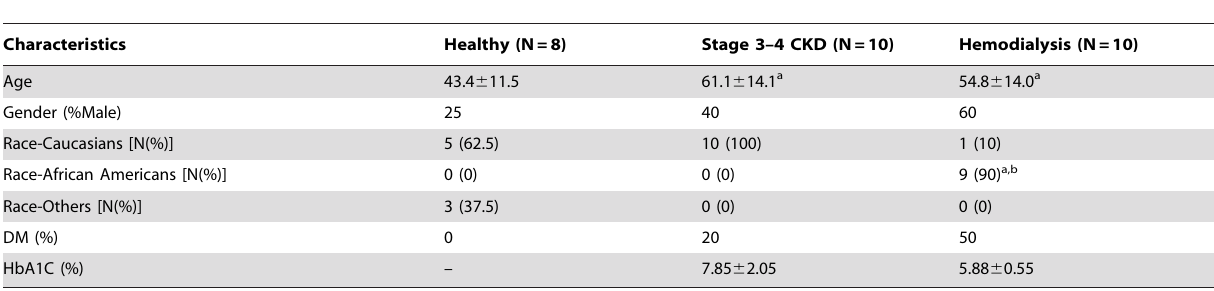
Table 2. Patient characteristics in a cohort of freshly isolated miRNA samples.